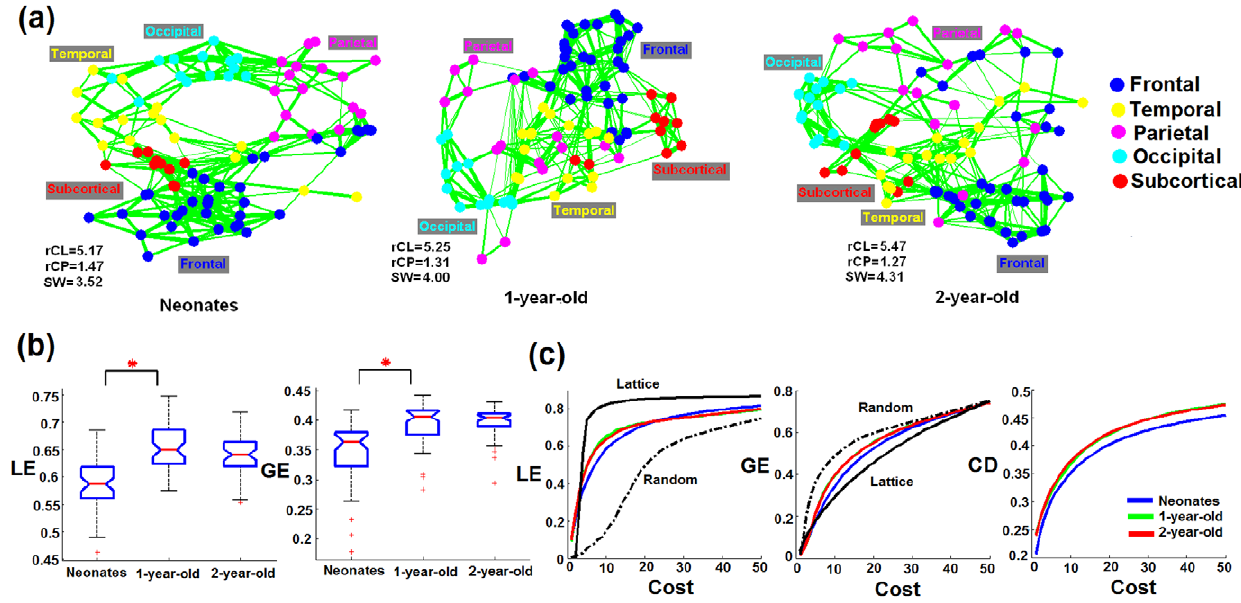
Figure 2. The evolution of brain’s topology and small-world properties. (a) The group mean correlation matrices at a cost of 10% are visualized using spring embedding plots for all three groups. Nodes are color coded with respect to the lobe they belong to. Each edge represents the mean connectivity strength between a pair of nodes. The rCL and rCP represent rCl ~ Cl = Cl clustering coefficient and characteristic path length for a given subgraph and the subscript ‘‘random’’ indicates a random network. SW represents the small-worldness measure; (b) Statistical comparison of LE and GE at cost 10% based on individual subject’s correlation matrices. Red asterisks represents significant difference at p , 0.05 (FDR correction); (c) LE, GE, and CD curve across the cost range of 1% to 50%. Significant increase of LE occurs from neonates to 1 yr olds for a range of cost spanning from 2% through 21% and GE from 4% to 44% (p , 0.05, FDR corrected). The calculation was based on individual subjects and the mean values for each age group are plotted.